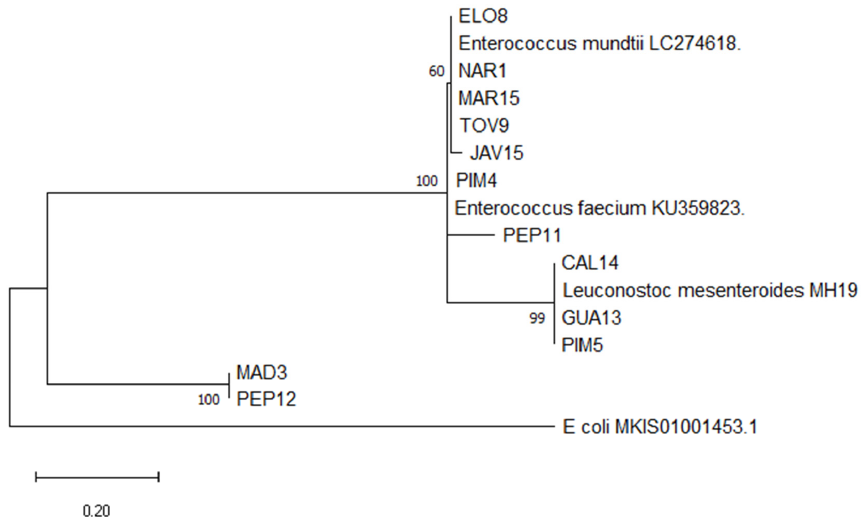
Figure 3. Phylogenetic tree of LAB isolated from fresh vegetables. The 16s rDNA gene sequences were aligned and the evolutionary distribution was inferred by applying the Maximum Likelihood